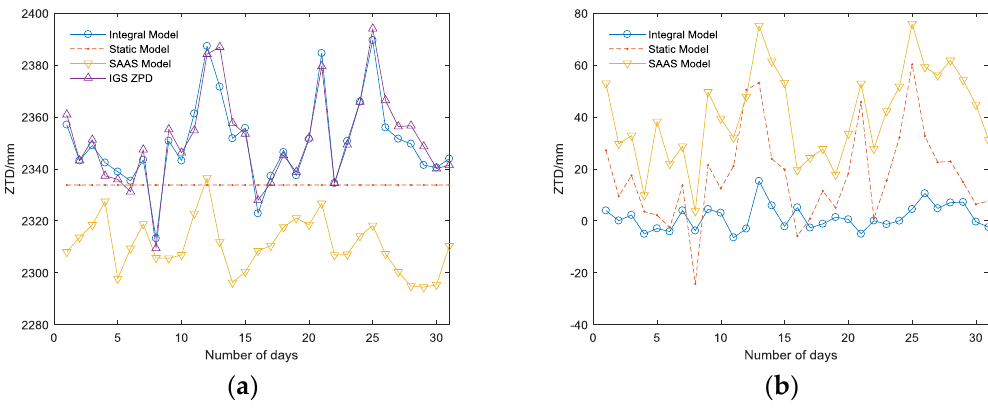
Figure 4. ( a ) The IGS ZPD variations and ZTD variations of the three models in December; ( b ) The DIFF between ZTD of three models and IGS ZPD in December.